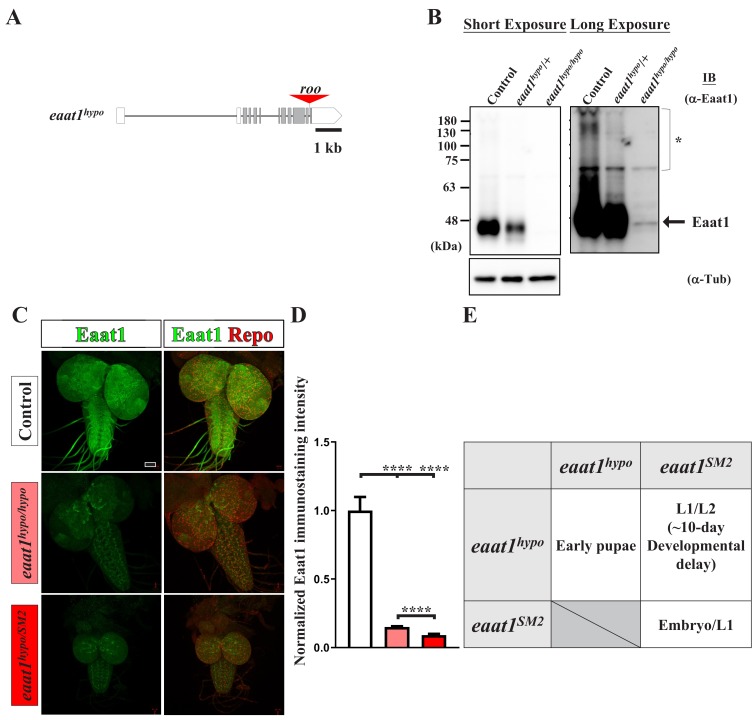
Characterization of the eaat1hypo mutant allele.(A) The eaat1 locus comprises twelve exons, including 5' and 3' UTRs (white boxes) and coding regions (gray boxes). A roo transposon element is translocated into the last intron of eaat1 in the eaat1hypo allele. (B) Western blotting of α-Eaat1 indicates a severe reduction in Eaat1 protein from the eaat1hypo allele in lysates of larval brain and VNC. The VNCs of third instar larvae of controls (w1118), eaat1hypo/+, and eaat1hypo/hypo mutants were used. α-Tubulin level served as a loading control. * indicates potential posttranslational modifications and dimerization of the Eaat1 protein. (C,D) Eaat1 is largely absent from eaat1 mutants. (C) Representative confocal images of larval brain and VNC co-stained with α-Eaat1 (green) and α-Repo (red) obtained from controls (w1118), eaat1hypo/hypo mutants, and eaat1hypo/SM2 mutants. Scale bar: 20 μm. (D) Quantification data for the immunostaining signal intensity of Eaat1, normalized to the value of the controls. (E) Loss of eaat1 compromises animal development and viability. ~20% of eaat1hypo/hypo mutants survive until the early pupal stage. However, eaat1SM2/SM2 mutants die as embryos or as first instar larvae (L1). eaat1hypo/SM2 mutants exhibit significant developmental delay (~10 days) and mostly died as first instar larvae (L1) and second instar larvae (L2). ~1% of eaat1hypo/SM2 larvae survived to the third instar larval stage. P values: ****, p<0.0001. n: replicate number. Error bars indicate SEM. Statistics: one-way ANOVA with Tukey’s post hoc test.10.7554/eLife.47372.004Figure 1—figure supplement 1—source data 1.Source data for Figure 1—figure supplement 1.